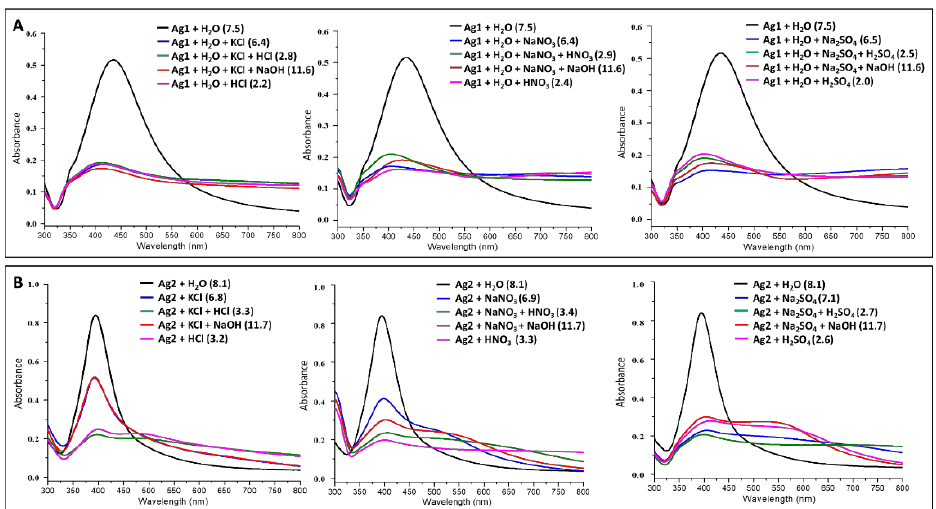
Figure 1. Electronic absorption spectra for pure and activated (using different activating agents as mentioned) ( A ) sodium citrate reduced silver nanoparticles (Ag1)—top panel and ( B ) sodium borohydride reduced silver nanoparticles (Ag2)—bottom panel. The pH values of different solutions are mentioned on the label of each graph.